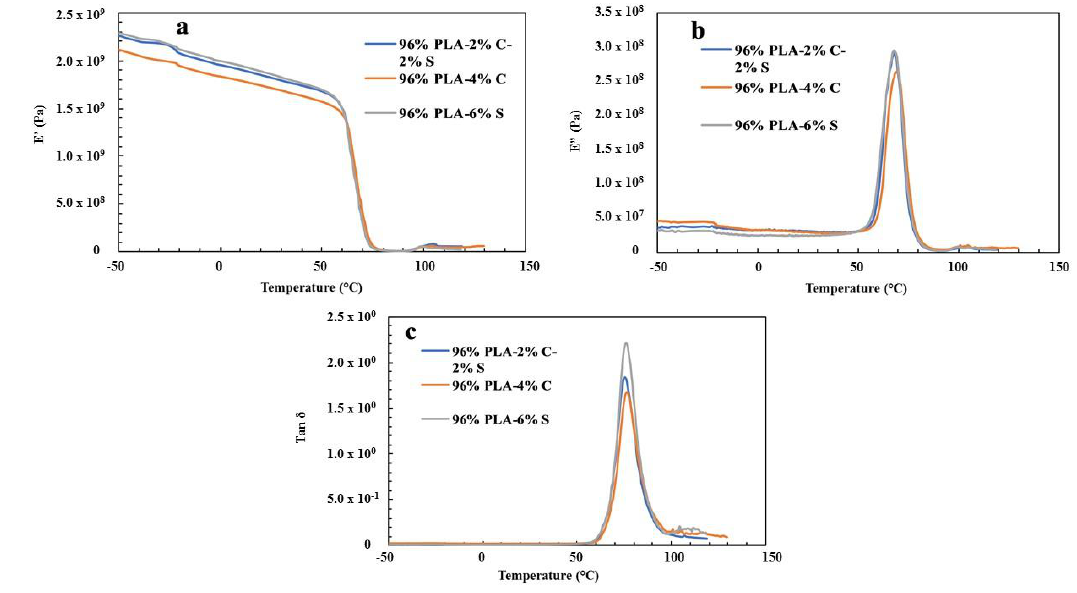
Figure 4. ( a ) Storage modulus (E’); ( b ) loss modulus (E”); ( c ) loss factor tan δ for 96% PLA–2% chitin–2% starch, 96% PLA–4% chitin and 96% PLA–4%